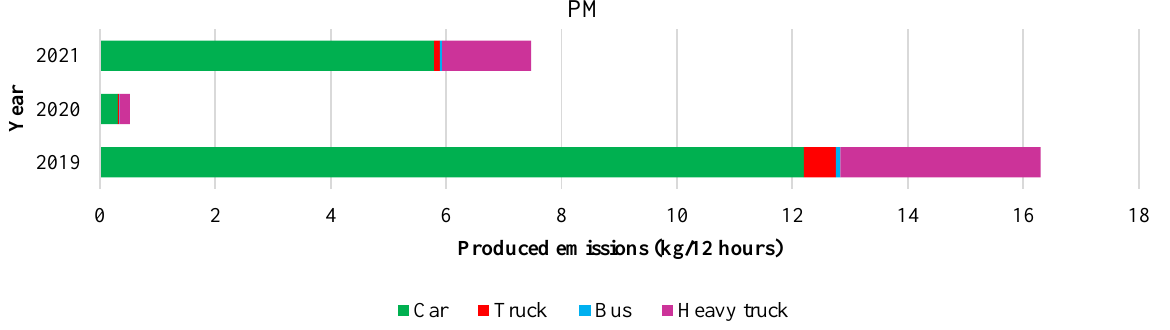
Figure 11. Estimation of PM production during the simulation.